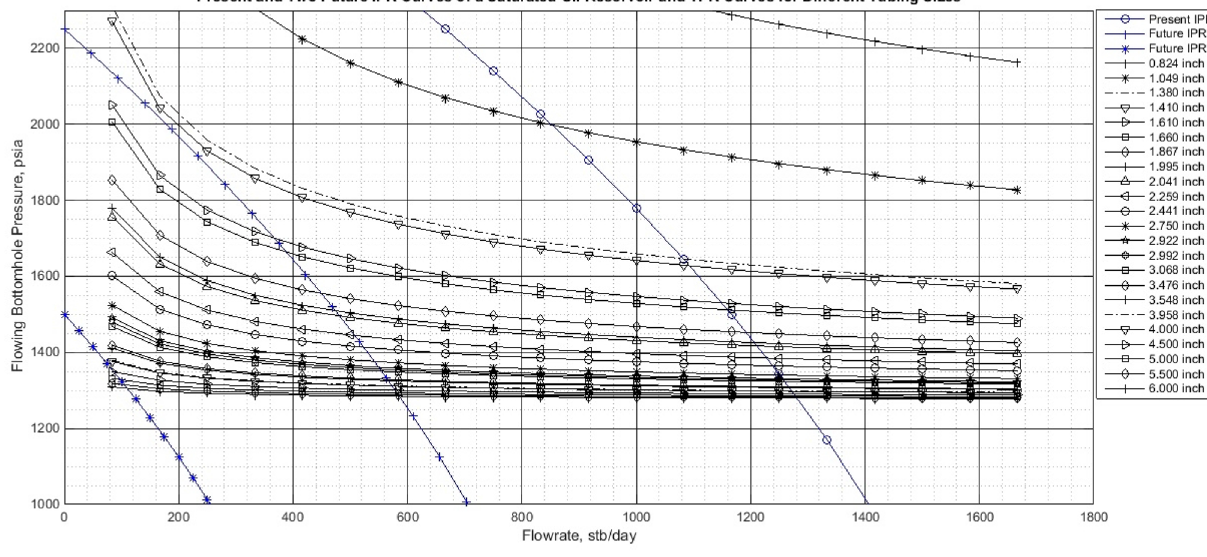
Fig. 3 Zoomed version of Fig.